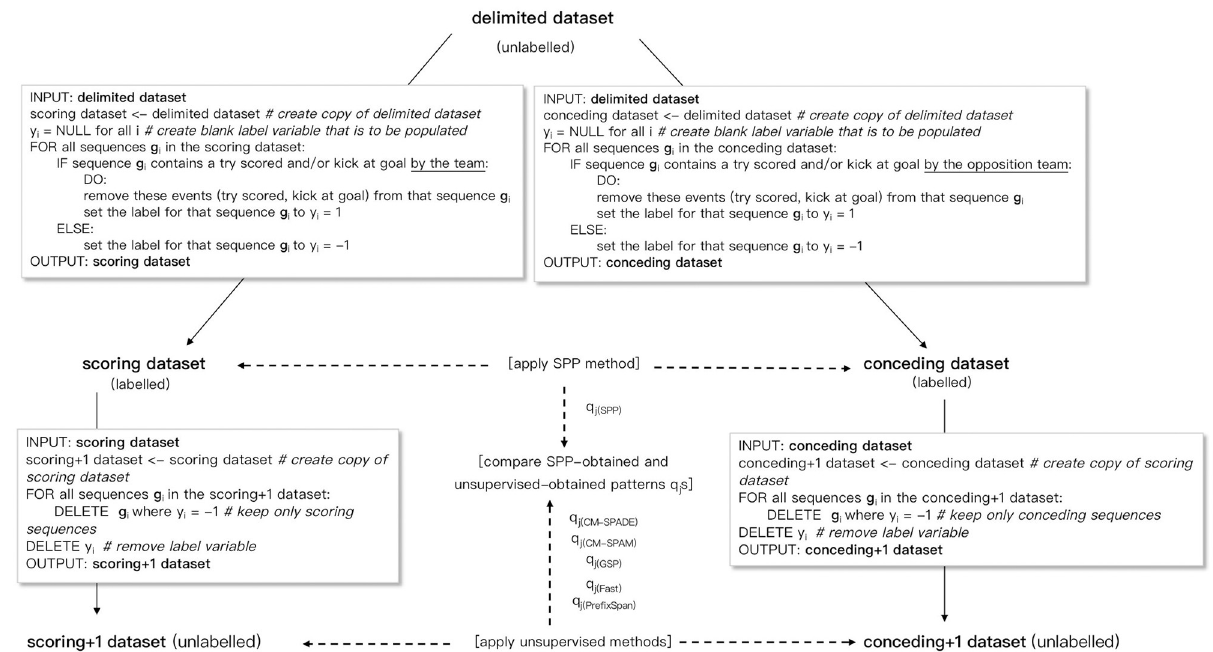
Fig 4. Illustration of dataset creation and experimental approach. Illustration of the procedures to create the datasets from the original delimited dataset to be used in the experiments and to compare the unsupervised and supervised SPM methods.